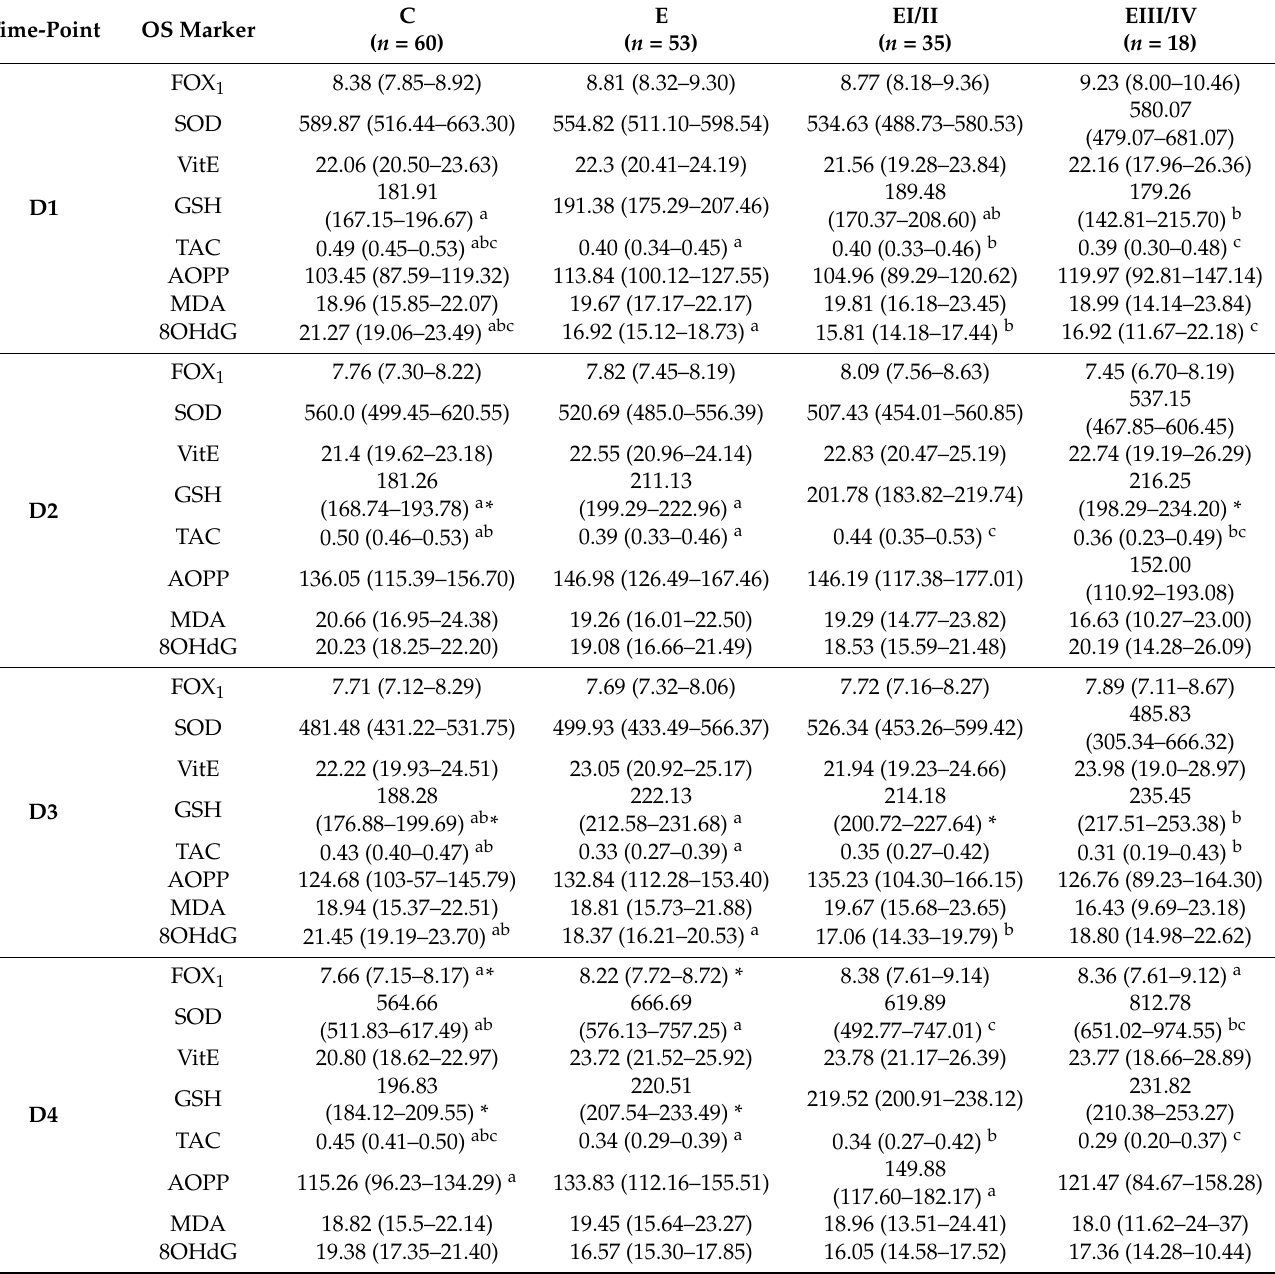
Table 2. Oxidative stress (OS) markers in serum samples obtained during the early follicular phase of the natural cycle prior to the beginning of controlled ovarian stimulation for ICSI (D1), after pituitary downregulation with GnRHa (D2), after hCG administration (D3), and on the day of oocyte retrieval (D4), comparing infertile women with endometriosis (regardless of disease staging—E), with early endometriosis (EI/II), and with advanced endometriosis (EIII/IV) and infertile controls